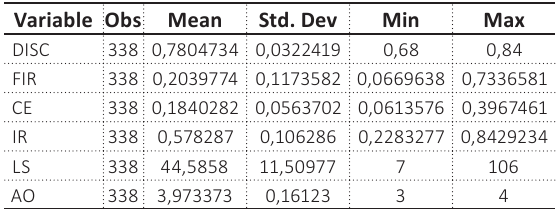
Table 3. Descriptive statistics